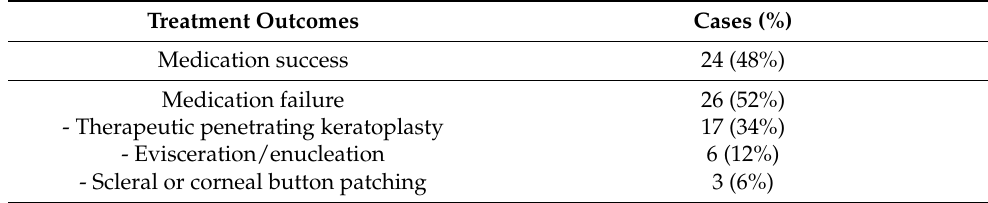
Table 5. Final treatment outcomes of dematiaceous fungal keratitis ( N = 50).